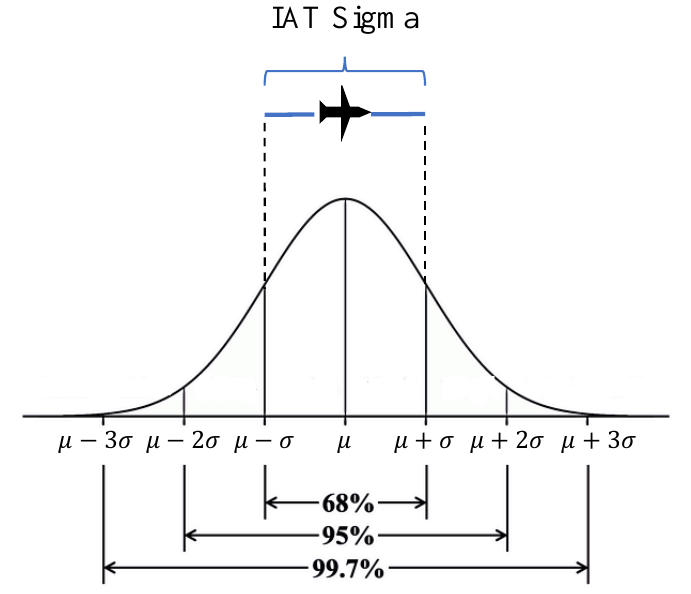
Figure 2. Inter-Aircraft Time Sigma (IAT Sigma).